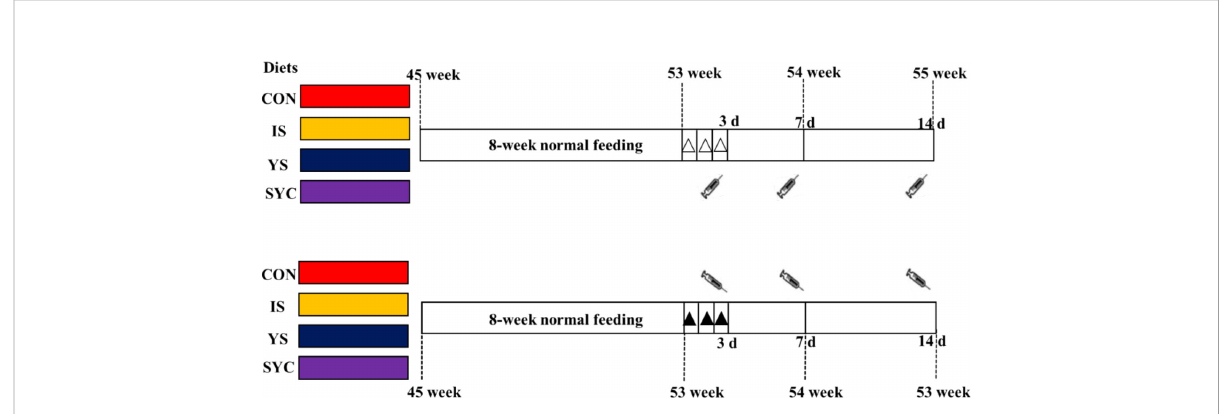
FIGURE 1 Experimental design for the timeline of supplementation of different Se sources and birds challenged with S. Enteritidis . : blood sampling at 3, 7, and 14 days after the challenge with S. Enteritidis , △ : challenged with physiological saline solution, ▲ : challenged with S. Enteritidis